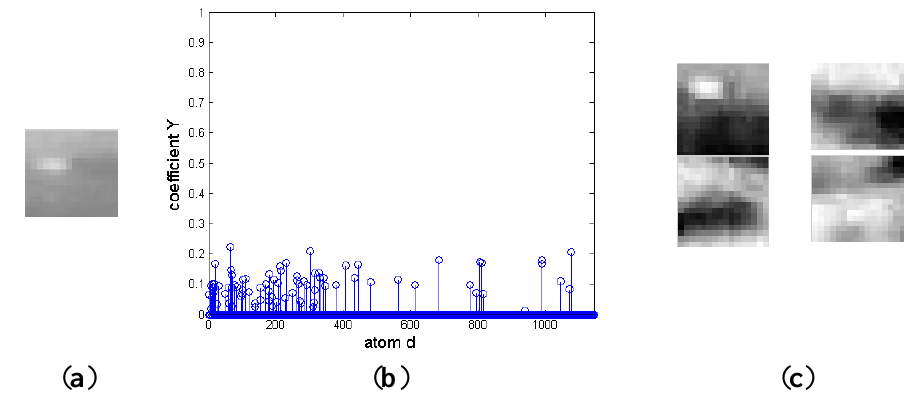
Figure 1. Decomposition of a target image block on adaptive morphology over-complete dictionary. ( a ) Target image block. ( b ) Representation coefficient. ( c ) Four atoms with maximum